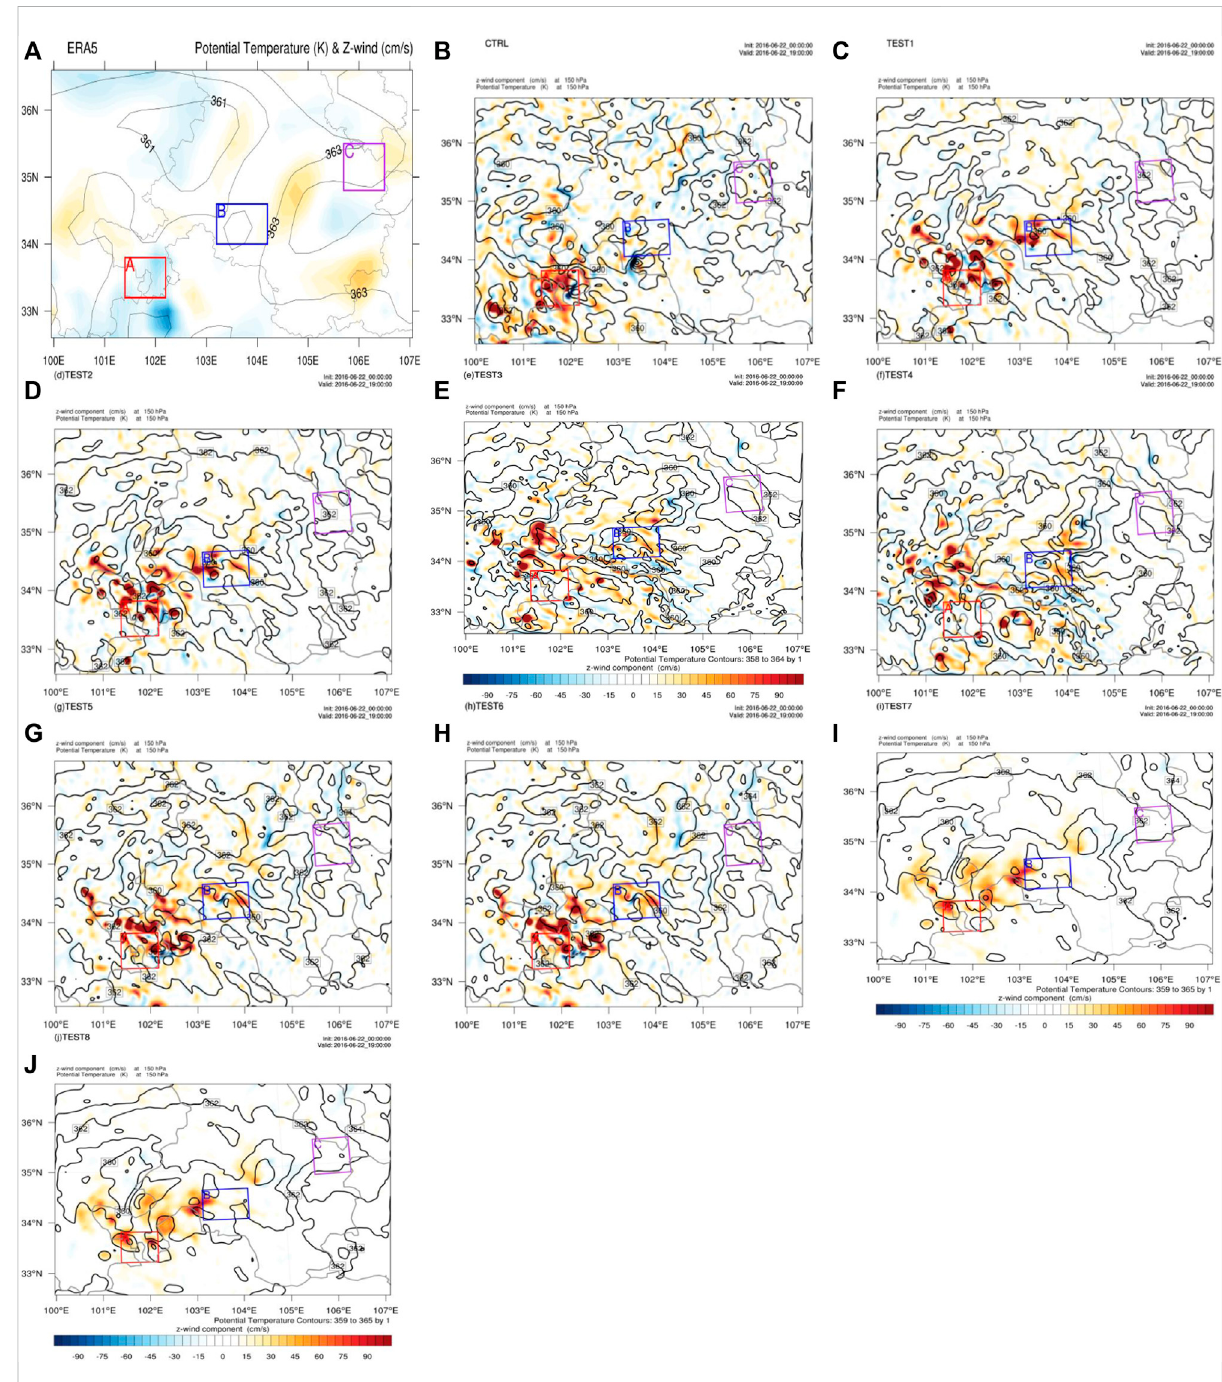
FIGURE 3 150 hPa pseudoequivalent potential temperature level distribution map (unit: